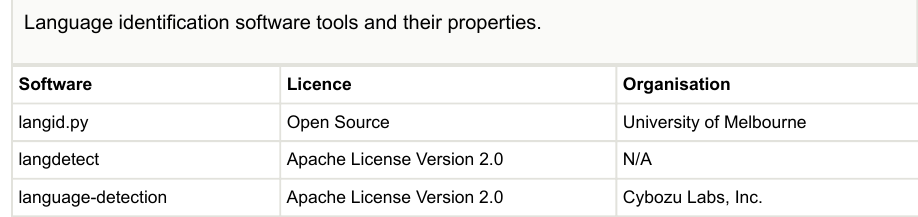
Table 7 provides output obtained by langid.py from a sample of our test data. The automatically identified language is quantified with a probability estimate. langid.py is able to identify 97 different languages without requiring any special configuration. It generally outperforms langdetect (Danilák 2018) in terms of accuracy. langid.py is also reportedly the faster of the two (Lui and Baldwin 2012). The corpus used in the evaluation contained